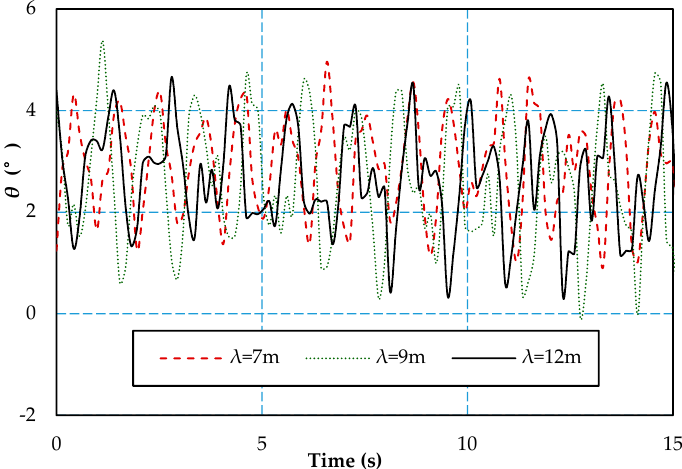
Figure 14. Oscillation curves of heave in different wavelengths.